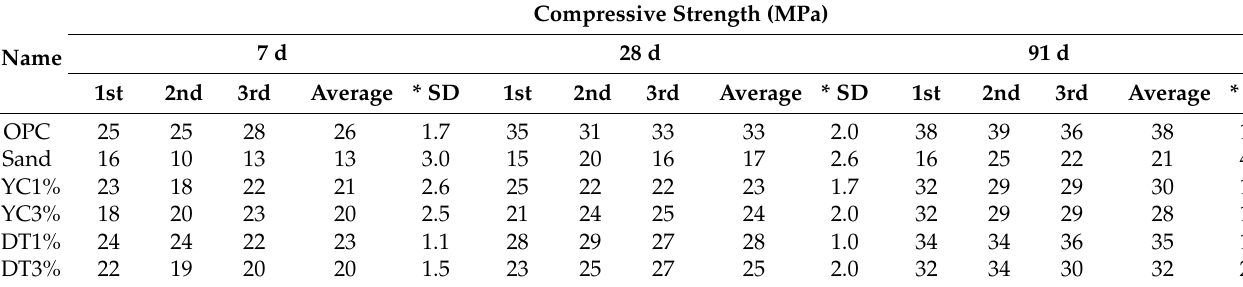
Table 6. Measurement of the physical test.